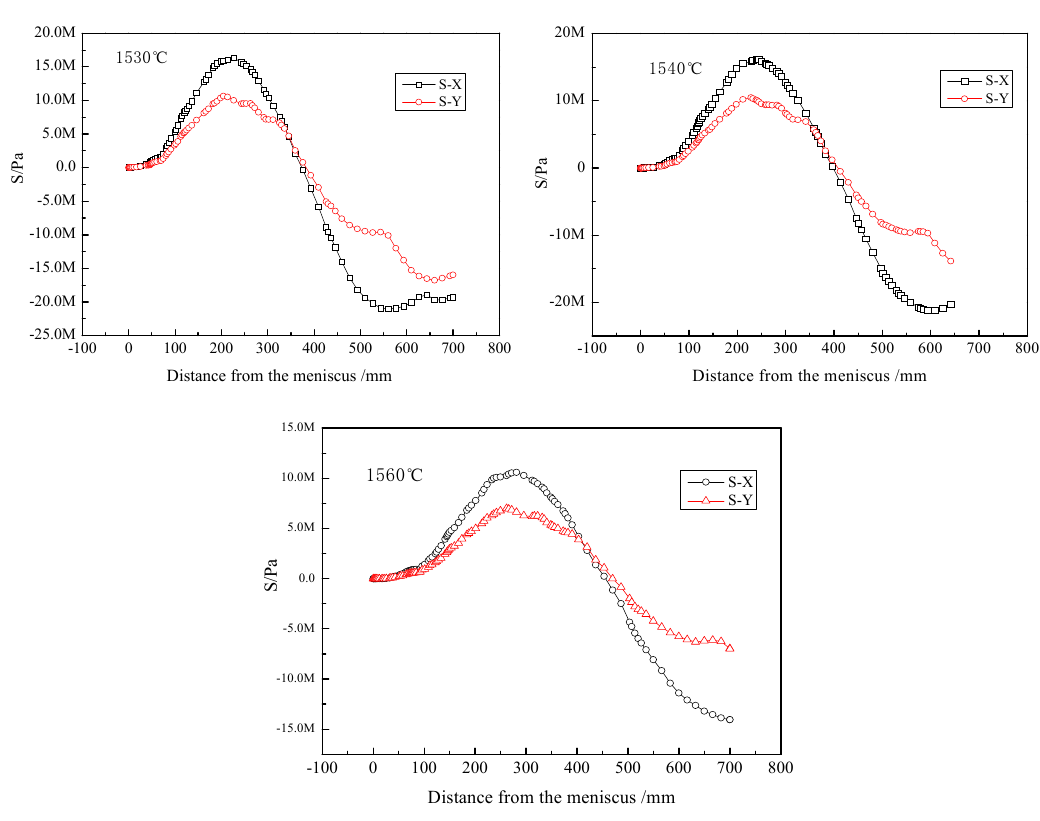
Figure 18. Stresses on the fillet at different pouring temperatures.